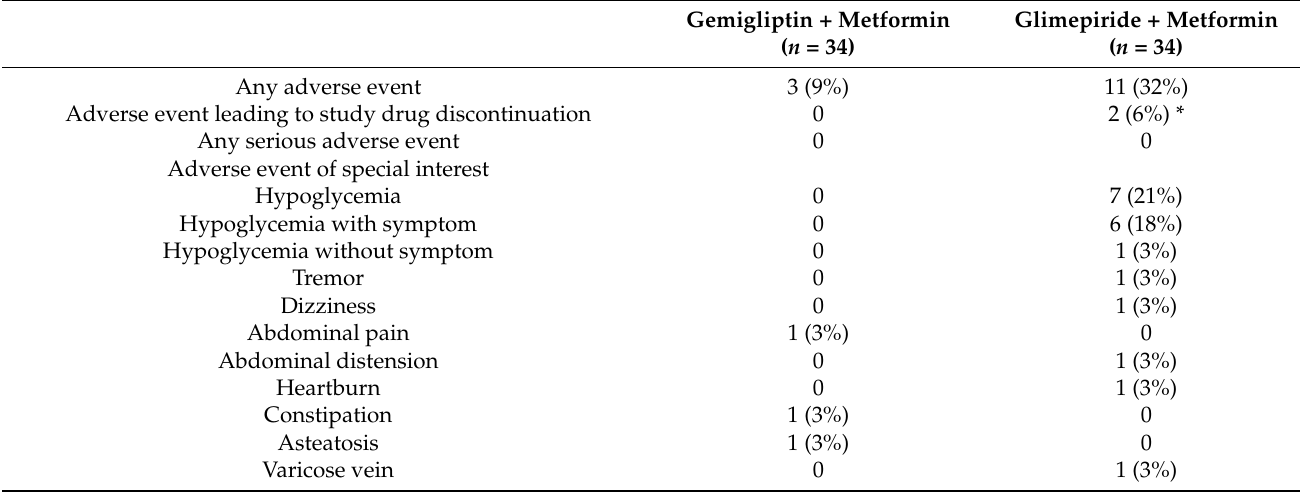
Table 3. Adverse events in both groups observed during the 24 weeks of